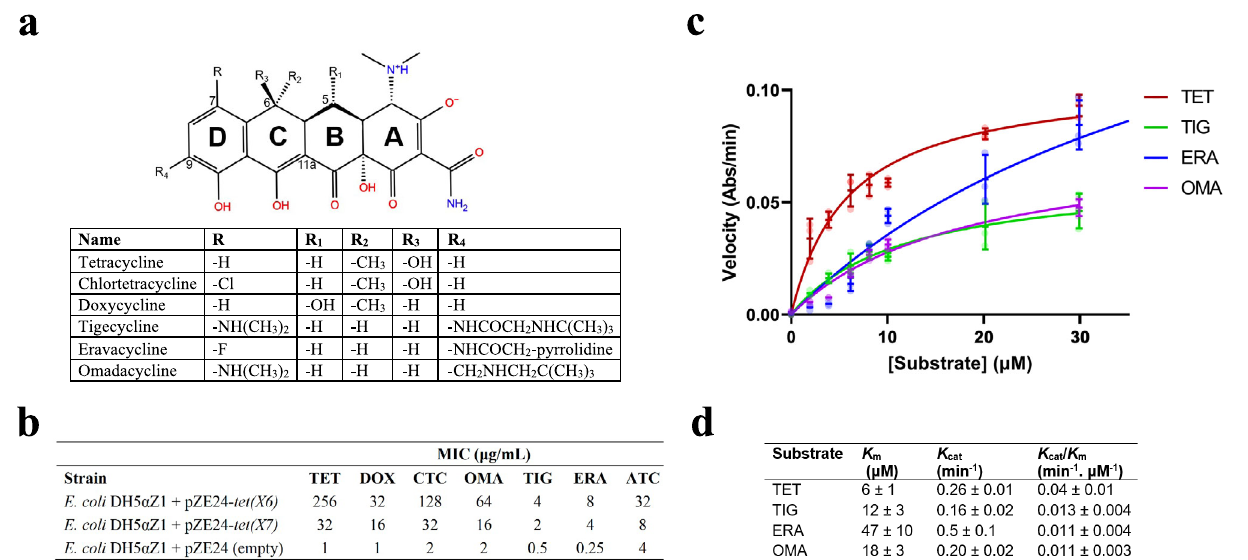
Fig. 2 Tet(X6) confers pan tetracycline resistance. a Chemical structures of different tetracyclines. b Tet(X6) confers high minimum inhibitory concentrations (MIC). Abbreviations: tetracycline (TET); doxycycline (DOX); chlortetracycline (CTC); omadacycline (OMA); tigecycline (TIG); eravacycline (ERA); anhydrotetracycline (aTC). c Michaelis-Menten curves for Tet(X6)-catalyzed degradation of tetracycline antibiotics. Note that the 65 µ M data point for eravacycline is omitted for uniform scale on the x -axis and the full plot is provided as Supplementary Fig. 5. d Apparent K m , k cat , and catalytic ef fi ciencies ( k cat / K m ) of Tet(X6) against different tetracyclines. Error values represent standard deviations for three independent